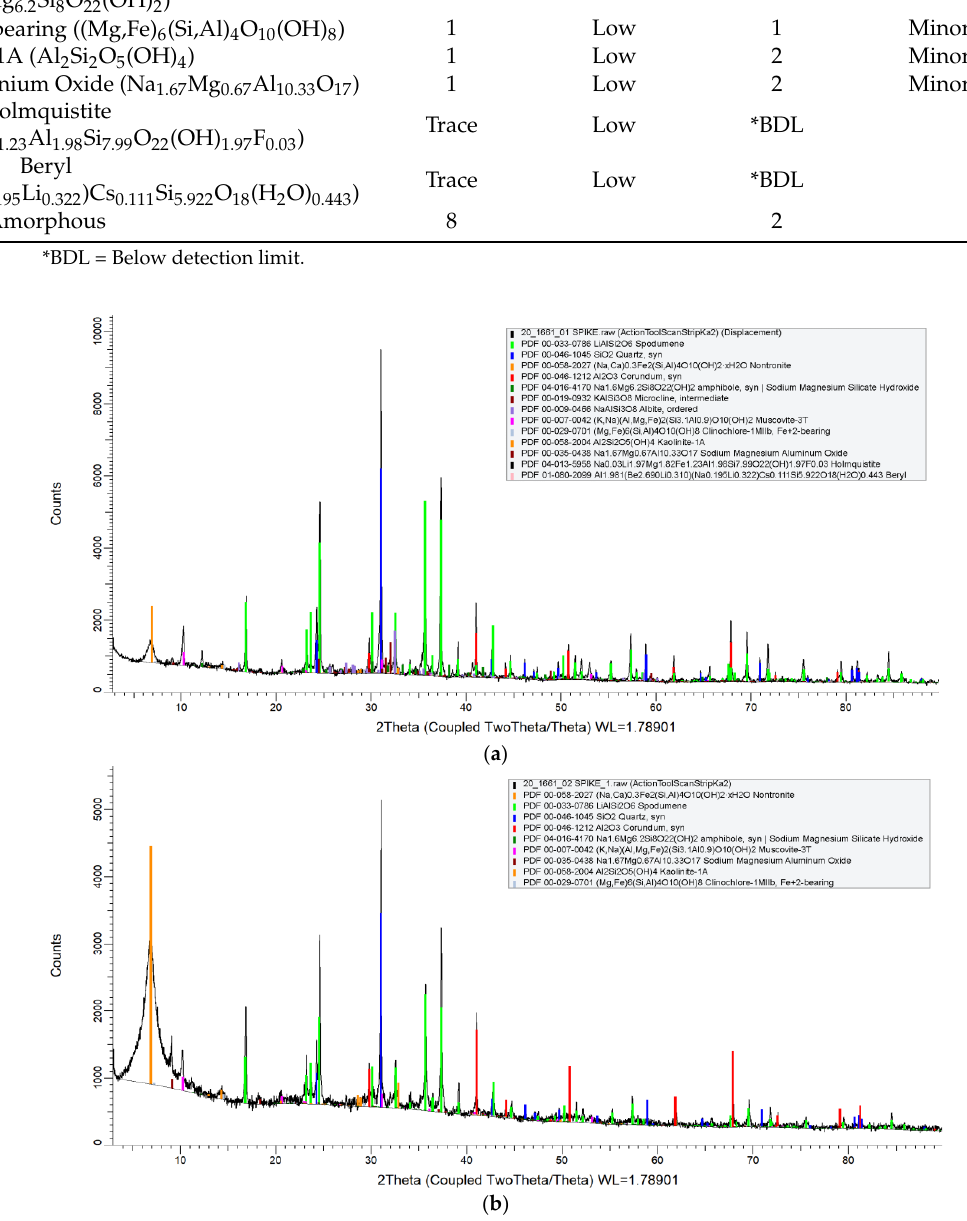
Figure 1. ( a ) XRD spectra of minerology of crystalline particles in chemical grade α -spodumene concentrate test sample, ( b ) XRD spectra of minerology of crystalline particles in technical grade α -spodumene concentrate test sample.